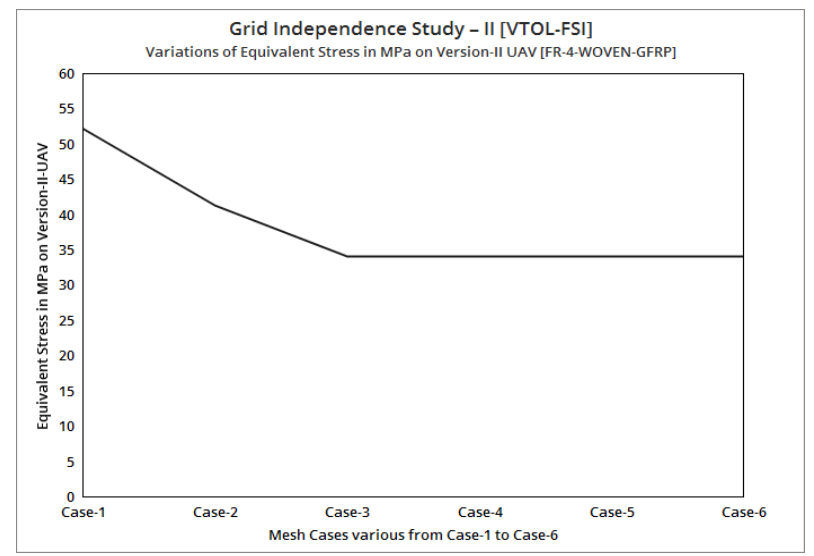
Figure 6. Grid independent study II (VTOL–FSI).